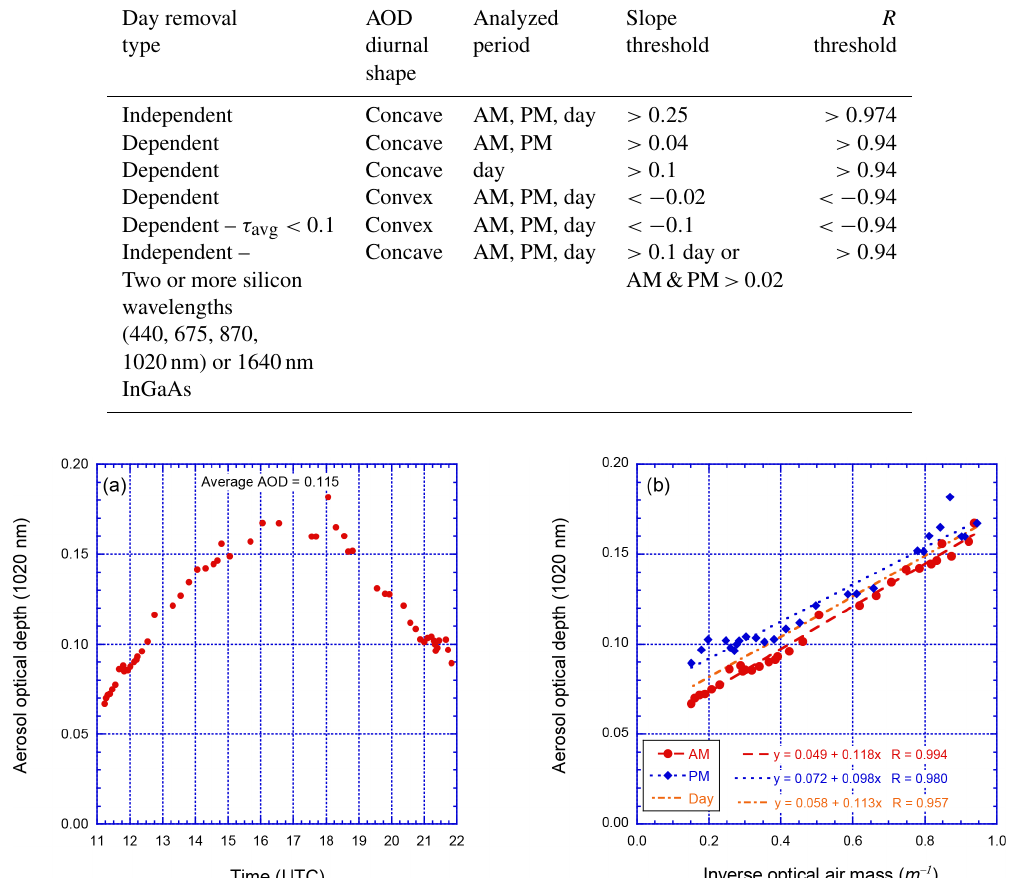
Figure 10. AERONET data collected at Rio Branco (lat − 9.96, long − 67.87) on 30 August 2011. The AOD 1020nm Level 1.5 with only the cloud-screening algorithm applied to the data. (a) The AOD diurnal dependence presents a concave shape during the solar day. (b) The AOD 1020nm and the inverse optical air mass show a highly correlated linear fit and the slope is significant for the full day (day), morning (AM), and afternoon (PM). Data separation for AM and PM is defined by the local solar noon, which is 16:31:28UTC at Rio